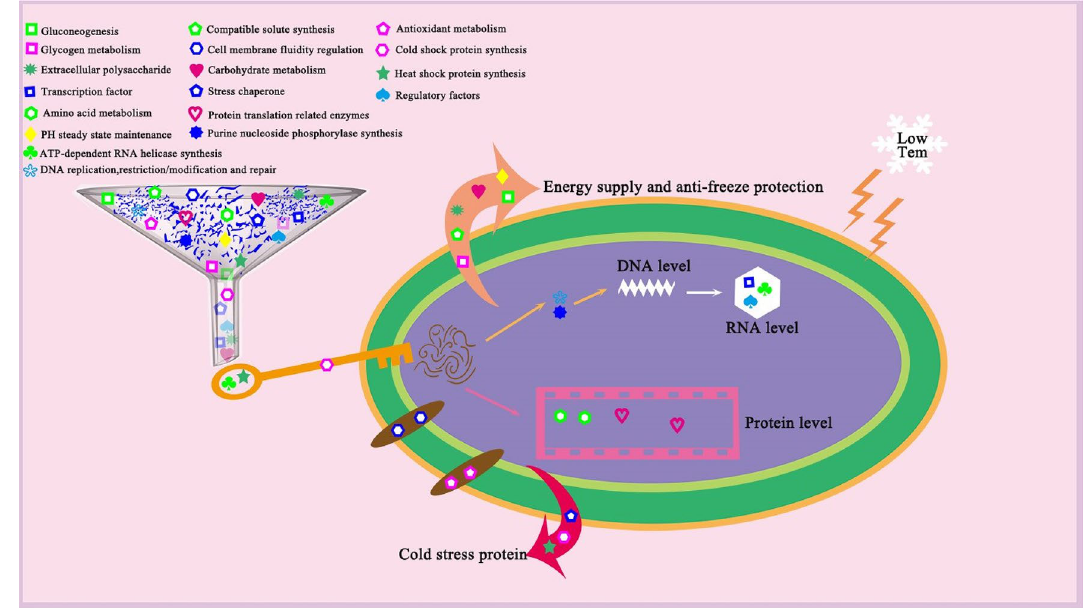
Figure 4. Strategies diagram for predicting cold tolerance of Bacillus sp.